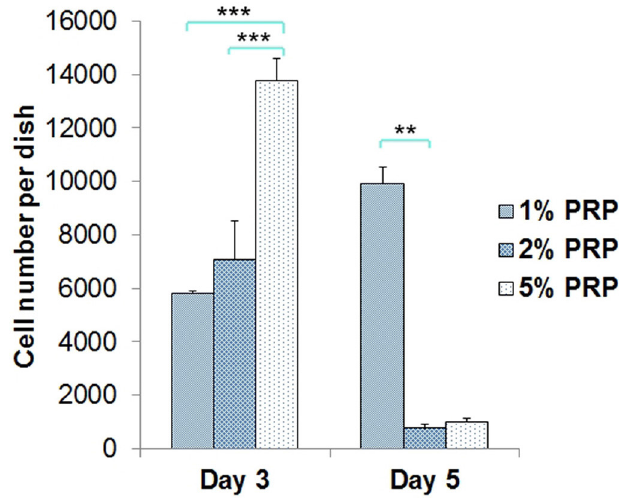
Figure 2- Cell number in media with PRP at day 3 and day 5 (** p<0.01, *** p<0.001)